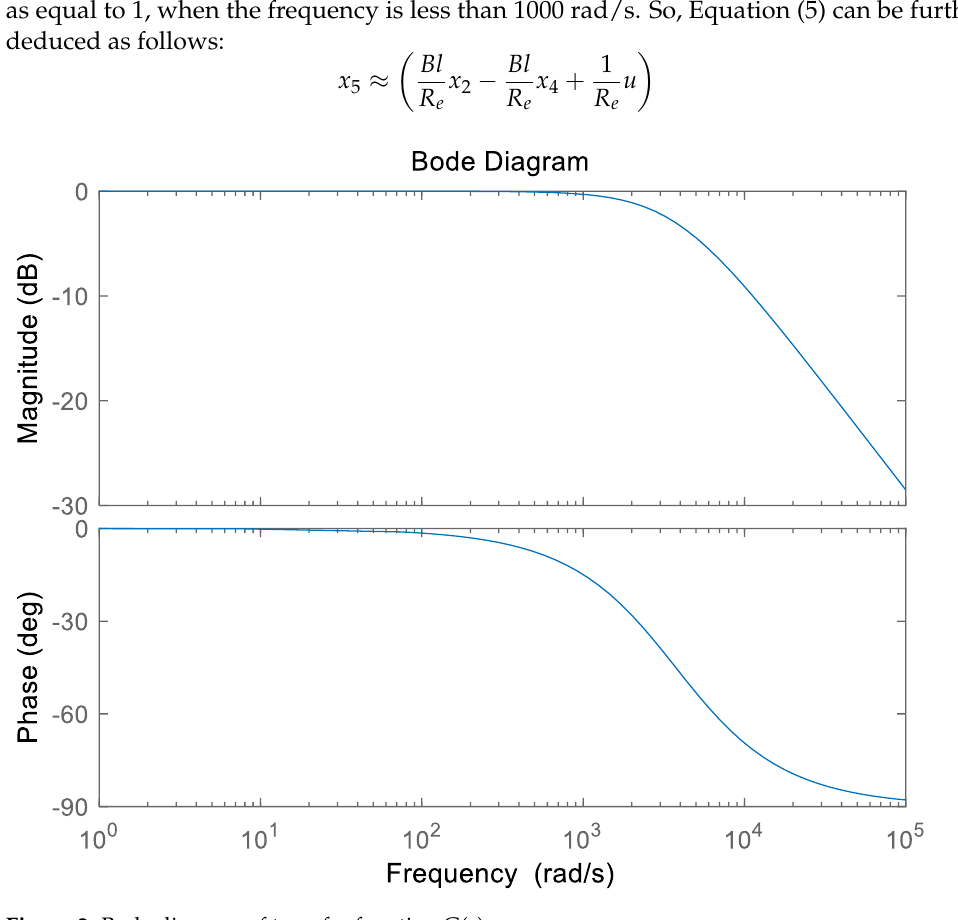
Figure 2. Bode diagram of transfer function G(s).